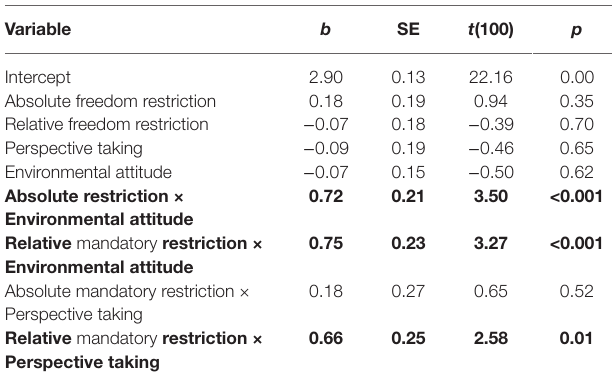
( Table 2 ). For high environmentally friendly people (+1 SD), TABLE 2 | Moderation analyses for variables predicting action evaluation ( N = 109) in Study